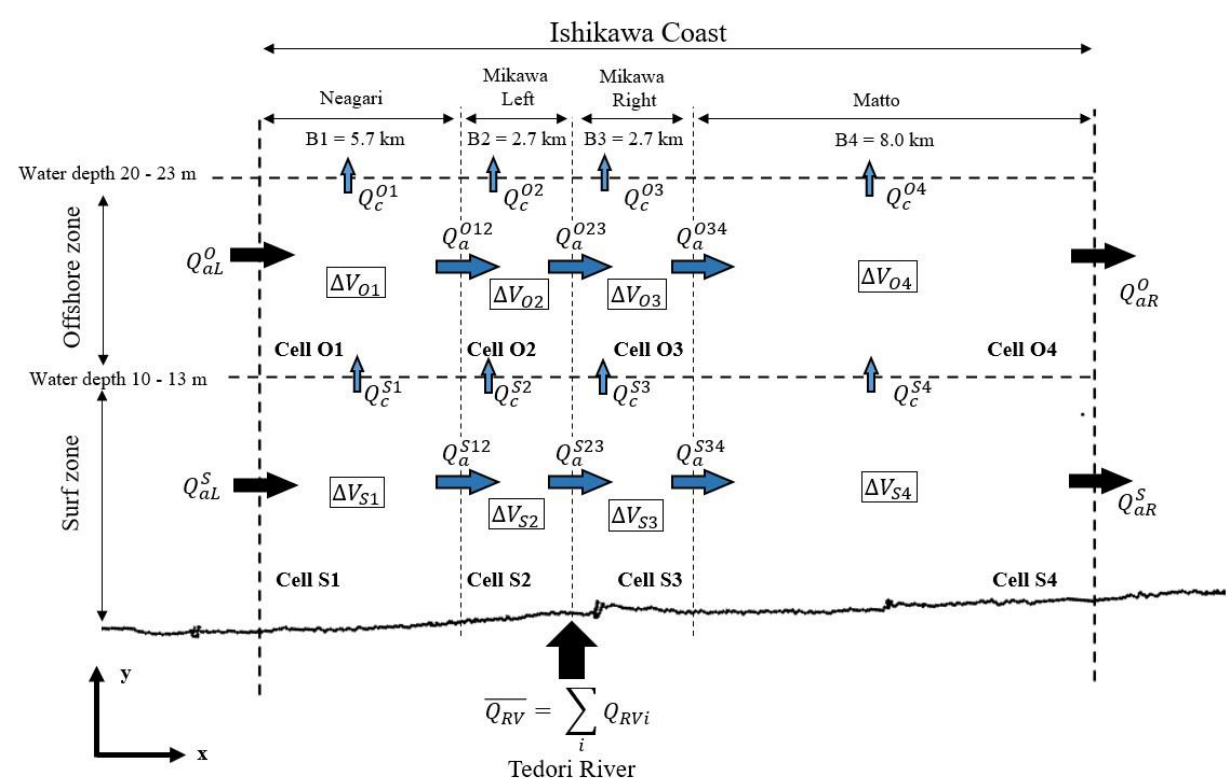
Figure 4. Sediment budget system for the Ishikawa coast analyzed in this study. The black arrows stand for all input data, both for longshore sediment transport and sediment disharge from Tedori river. The blue arrows represent all unknown variables for sediment transport rates between each cell in longshore and cross-shore directions.